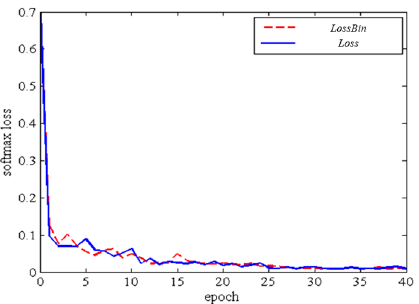
Figure 8. Loss curve with Loss Bin and Loss.